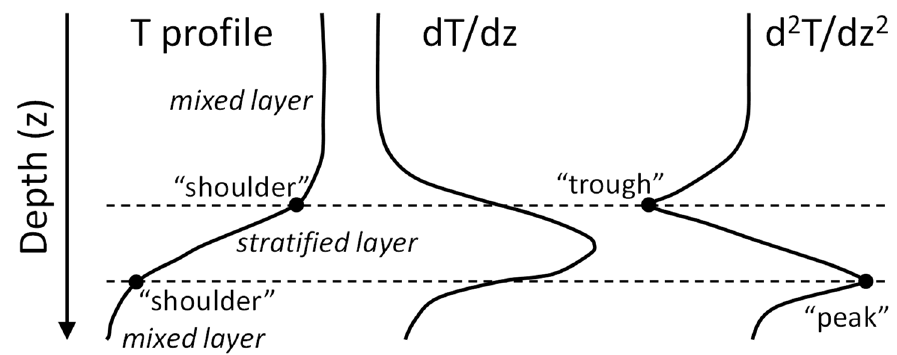
Figure 4. Sketch showing how troughs and peaks in the d 2 T/dz 2 profile identify boundaries between alternately (relatively) strongly- and weakly-stratified layers in the temperature profile.